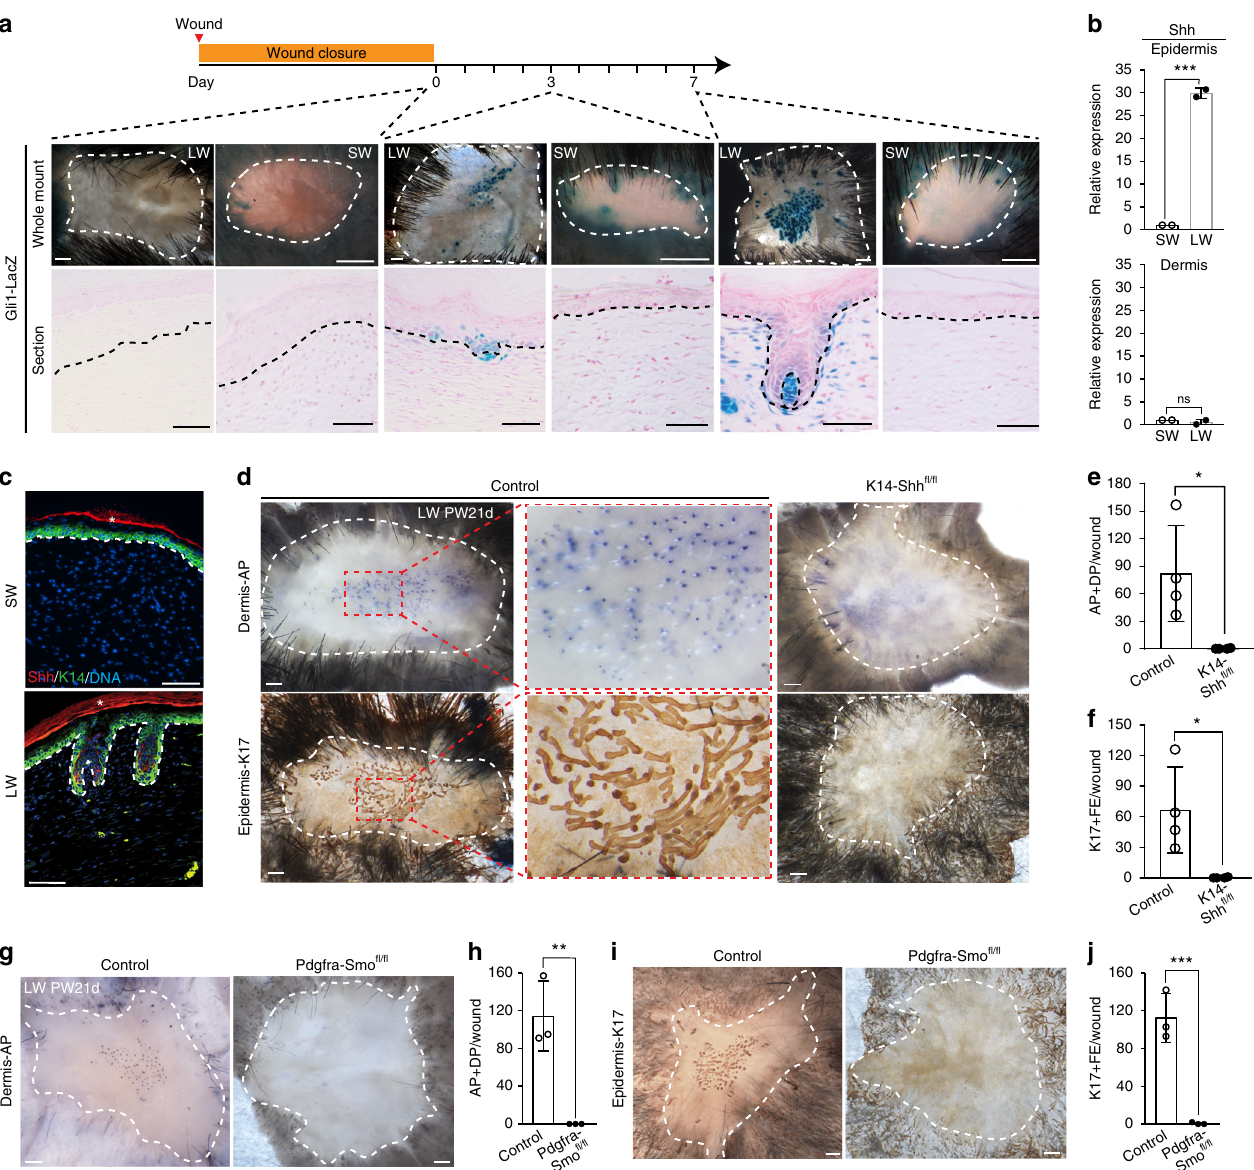
Fig. 1 Shh signaling is necessary for HFN following injury. a X-gal staining of large wound (LW) and small wound (SW) from of Gli1-LacZ mice at